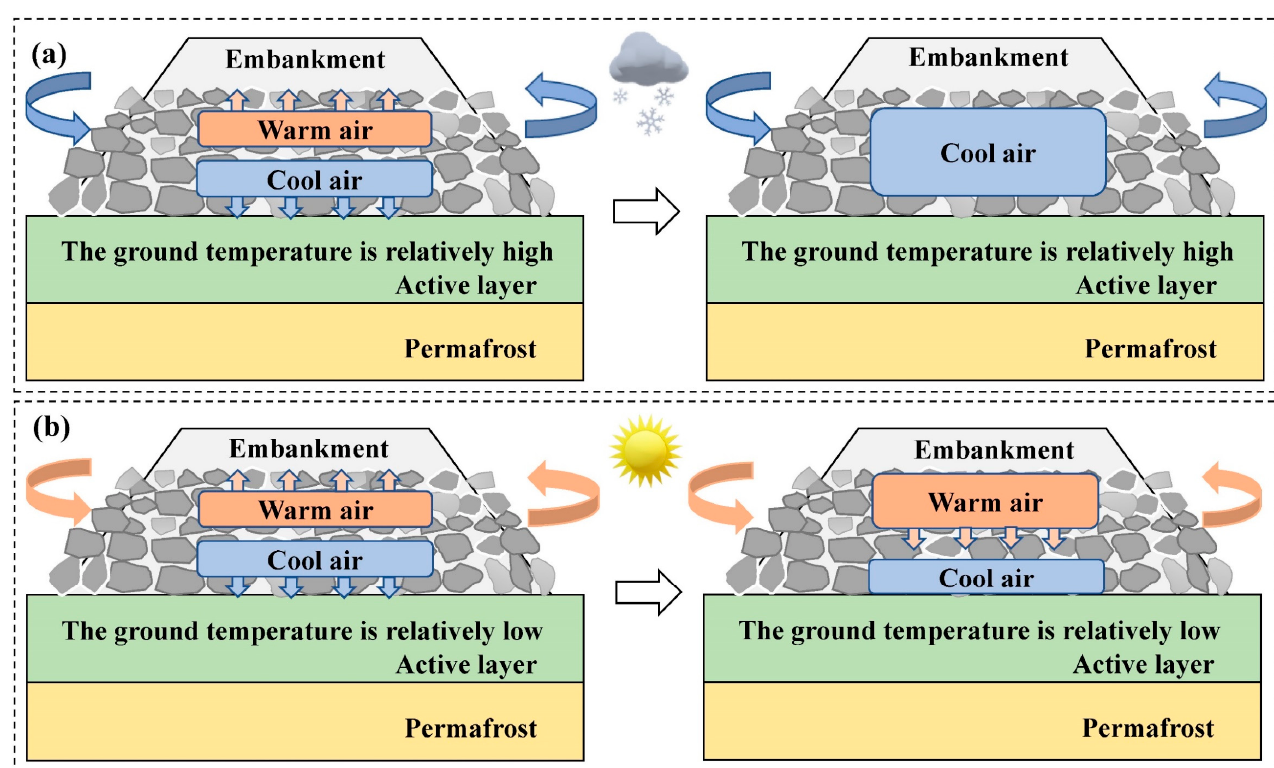
Figure 4. Schematic diagram of the working principle of a block-stone embankment: ( a ) cold season; ( b ) warm season.